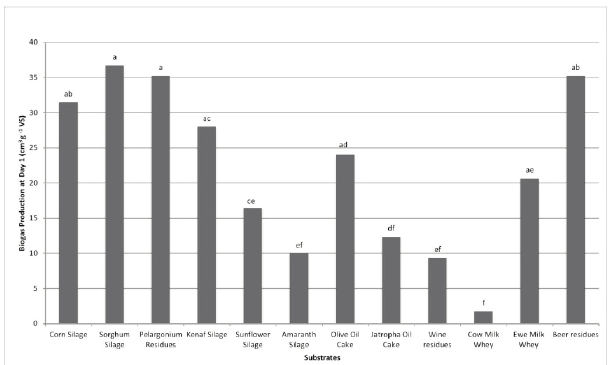
Fig. 1 - BioGas experimental production (cm 3 g -1 VS) for the (t1) different substrates. Different letters means significative differences between substrates according to Bonferroni Multiple Comparisons Test